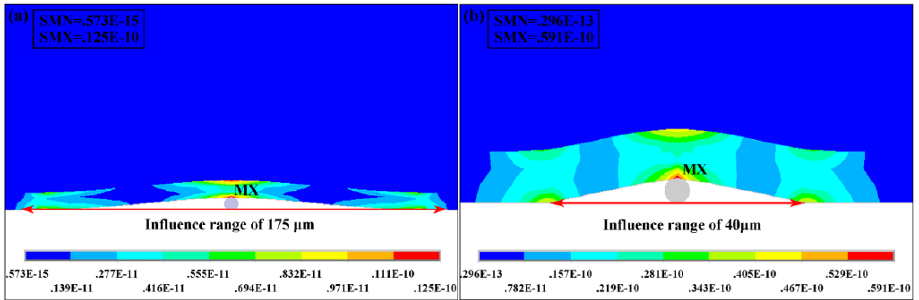
Figure 3. Von Mises stress distribution and influence range of composite mould for ( a ) particle radius of 6 μm under the pressure of 20 kPa and ( b ) particle radius of 2 μm under the pressure of 80 kPa.